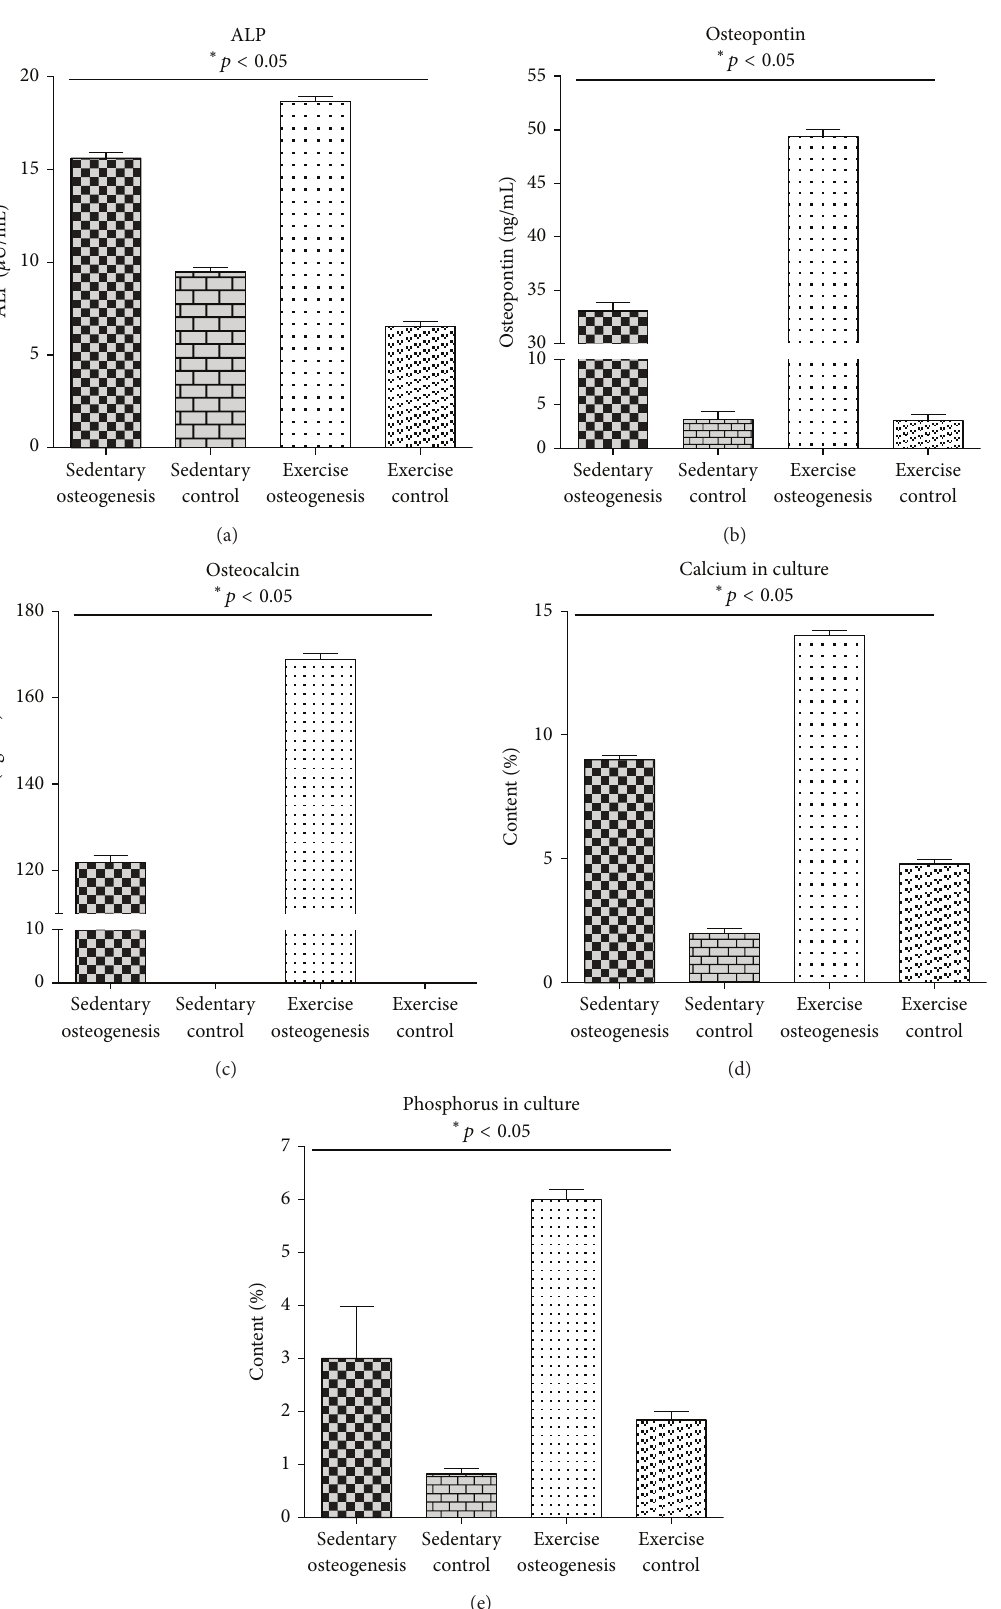
Figure 5: The activity of ALP (a) and the concentration of OPN (b), OCL (c), calcium (d), and phosphorus (e) measured on the 21st day of culture in osteogenic medium. Statistical significance ( 𝑝 < 0.05